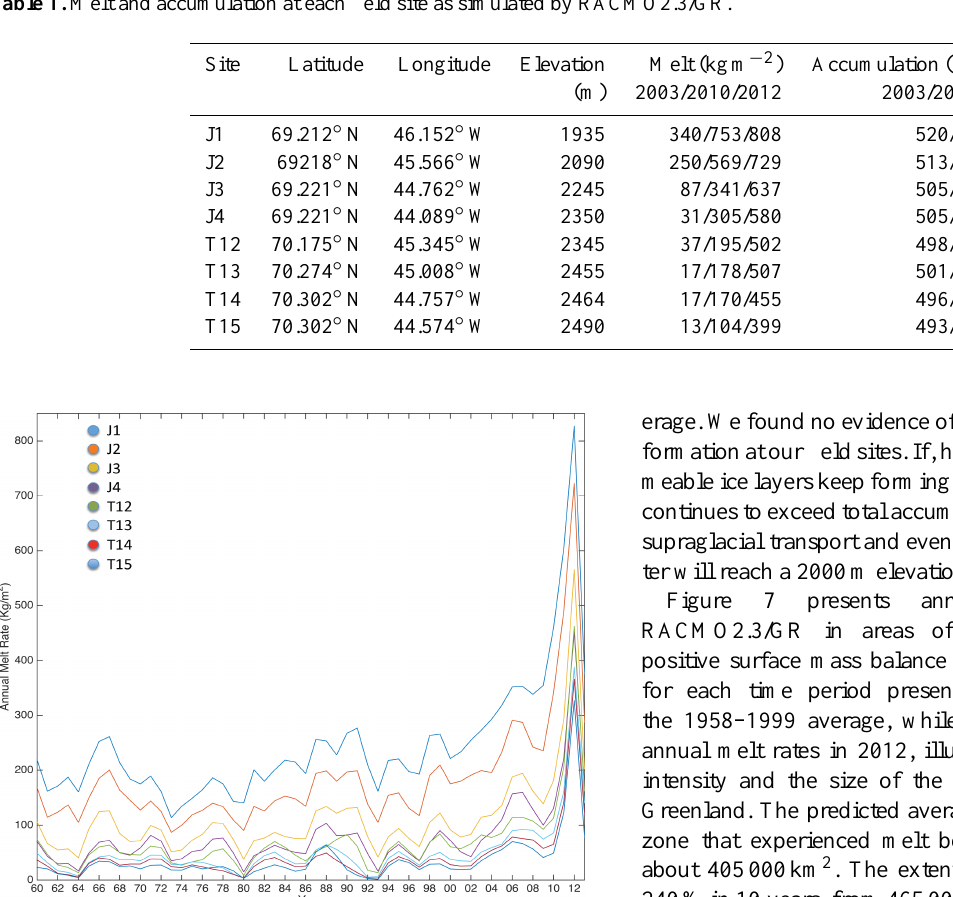
Table 1. Melt and accumulation at each field site as simulated by RACMO2.3/GR.